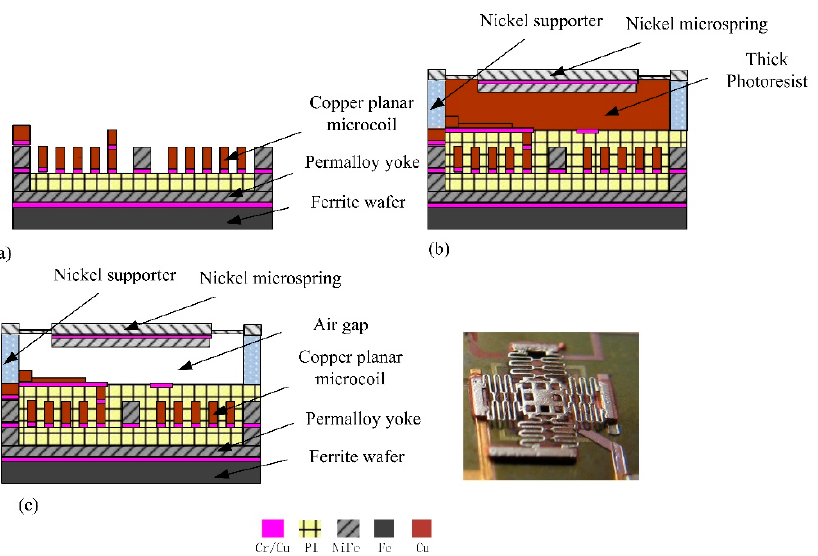
Figure 7. The fabrication process and the prototype.